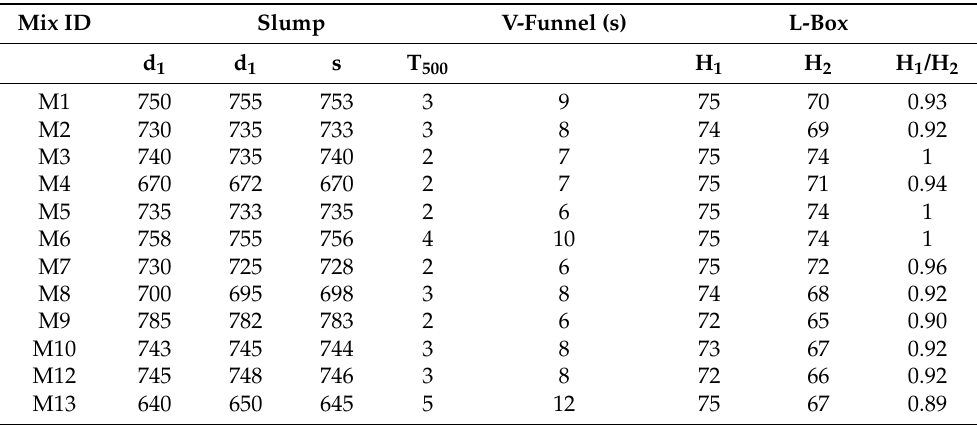
Table 7. Fresh properties of